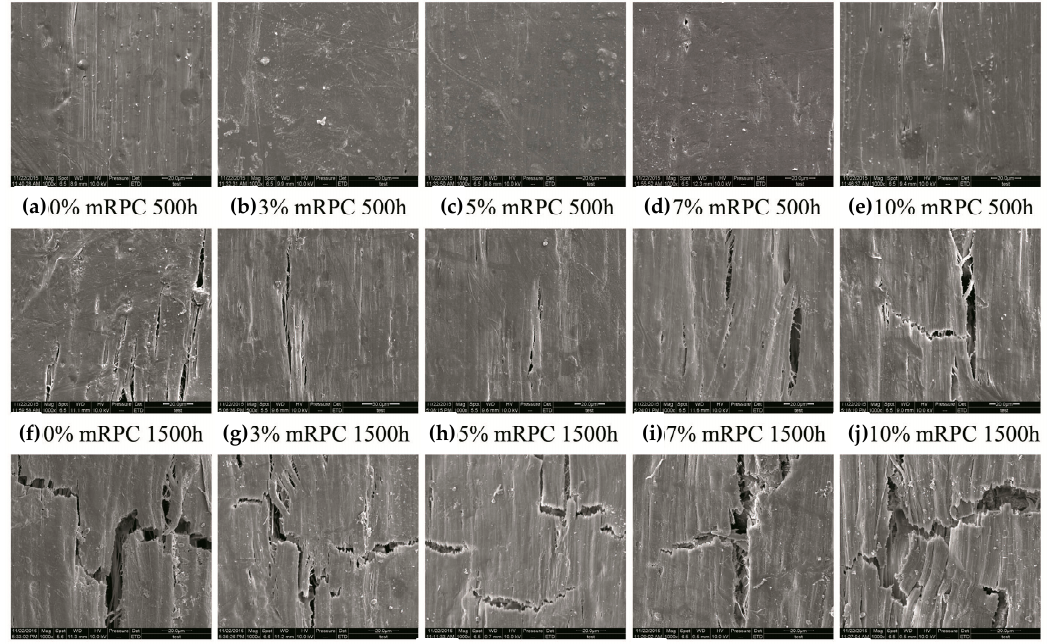
Figure 12. Surface morphology of the composite samples with different mRPC content after the UV-accelerated aging (magnification 1000×). UV-accelerated aging (magnification 1000 ×